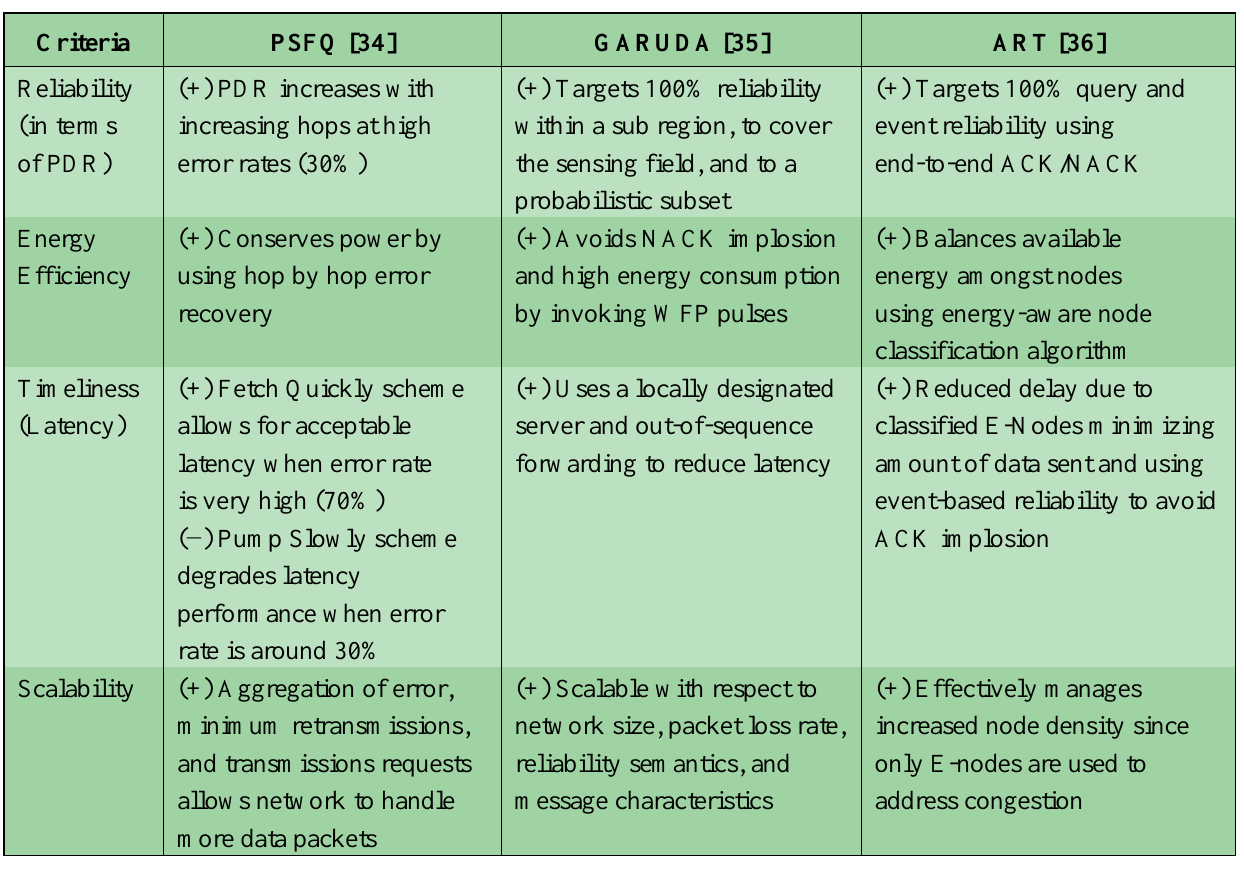
Table 4. Summary of reliable transport protocols for suitability in